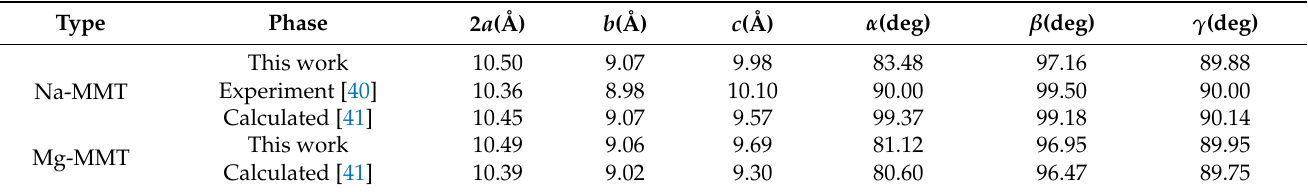
were listed in Table 2. According to the difference of the connected atoms, the oxygen atoms are divided into five kinds: O a is an oxygen atom connected to Al, Mg and H atom; O b is an oxygen atom connected to one H atom and two Al atoms; O c is an oxygen atom connected only to Si atom. O d is an O atom connected to Al, Mg and Si atom; O e is an O